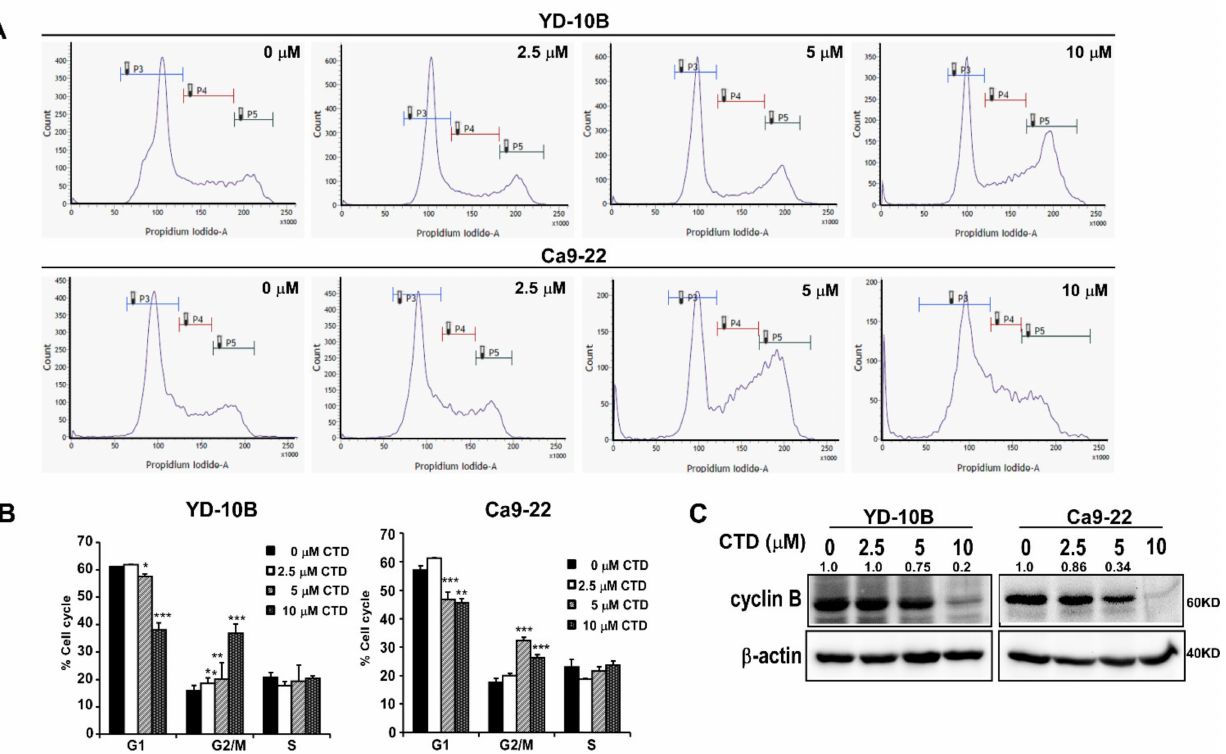
Figure 5. Costunolide induces cell cycle arrest in the G2/M phase of oral cancer cells. ( A ) Analysis of results from the cell cycle assay. Cells were treated with 0, 2.5, 5 or 10 µ M CTD and then incubated for 24 h. Data are shown as mean ± SD of values from triplicate samples. * p < 0.05, ** p < 0.01 and *** p < 0.001 indicate a significant difference compared with control. ( B ) Image indicating cell cycle distribution. ( C ) Expression of cell cycle markers in oral cancer cell